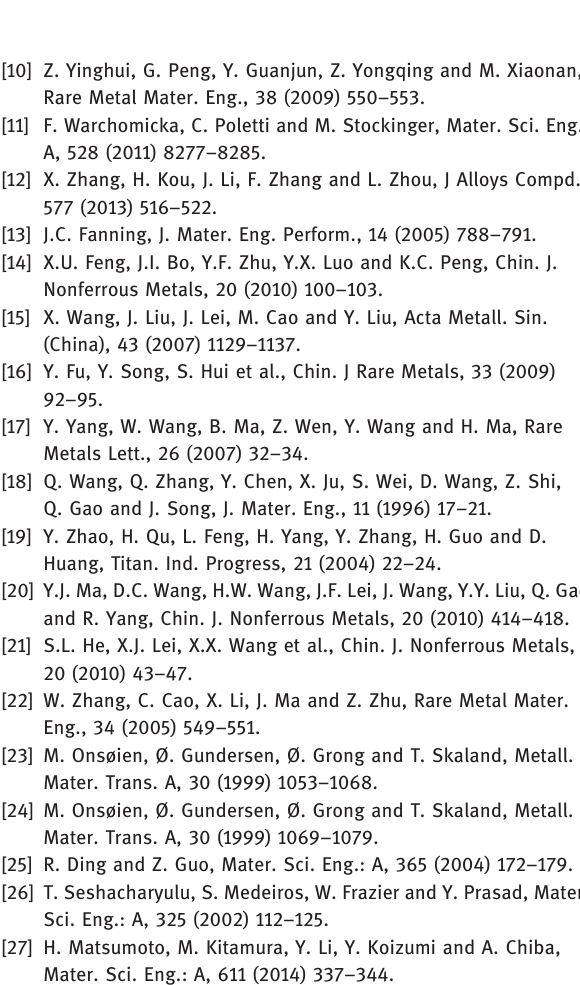
Figure 18: Distribution of grain boundary misorientationangles( β phase):(a) 750°C, 0.001 s − 1 ; (b) 800°C, 0.001 s − 1